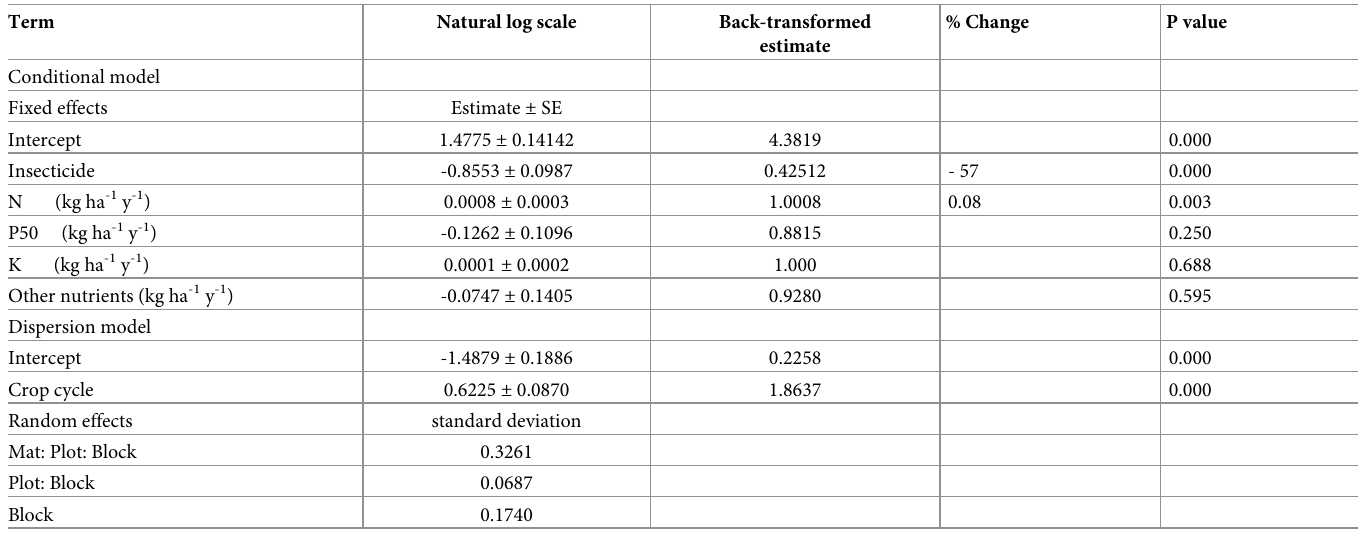
Table 4. Estimates, standard errors (SE), back-transformed estimates and per cent change in weevil damage as a function of insecticide and fertiliser application to EAHBs in the nutrient omission trial using a GLMM with a negative binomial distribution, log link function and Laplace approximation (n =